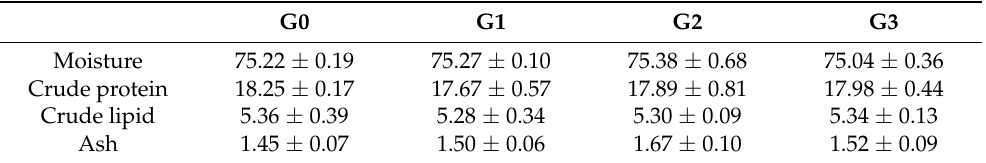
Table 4. Effect of fish meal replaced by unfermented and/or fermented soybean meal on whole body composition of the juvenile coho salmon (%/per g of wet weight).